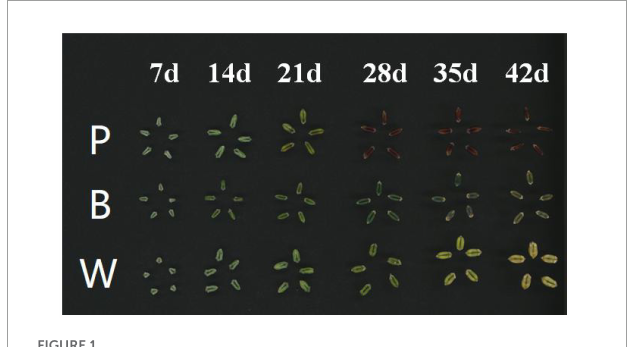
FIGURE1 Sampling seed map of wheat after flowering. The figure was obtained using a